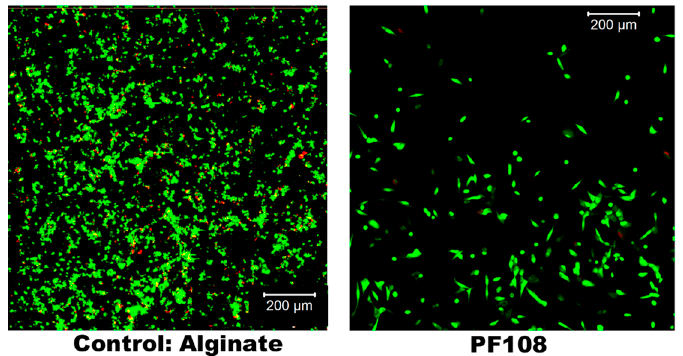
Figure 7. Representative live-dead assay stained images of cells cultured in SWCNT-PF108 composites (right) and pristine alginate gels (left).